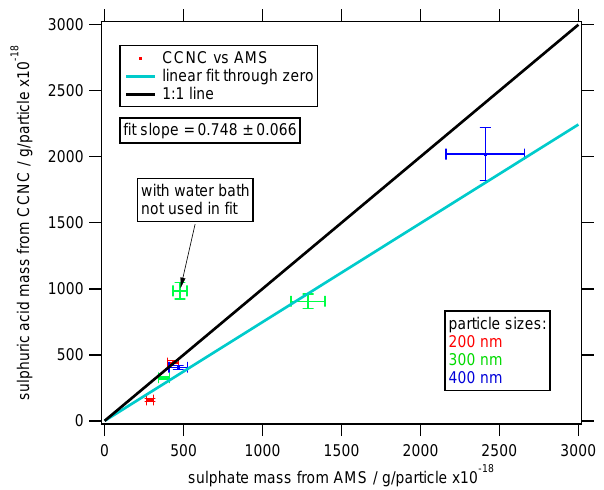
Fig. 8. Comparison of AMS sulphate per particle masses to CCNC soluble mass per particle for the FROST1 campaign. The outlying point was recorded with the water bath in use.